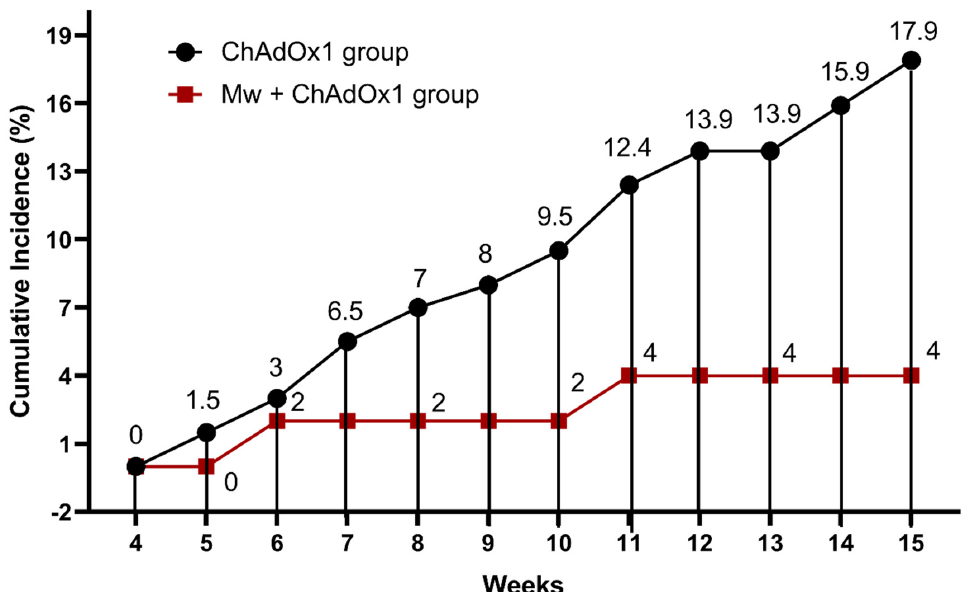
Figure 1. Impact of Mw + ChAdOx1 vaccination on COVID-19 compared to ChAdOx1 vaccination alone. Points and connecting line plot show the infection trend in the Mw + ChAdOx1 group (n = 50) and the ChAdOx1 group (n = 201). The x-axis shows the time in weeks and the y-axis shows the cumulative incidence (CI) in %. Red and black shaded circles represent Mw + ChAdOx1 and ChAdOx1 groups, respectively.